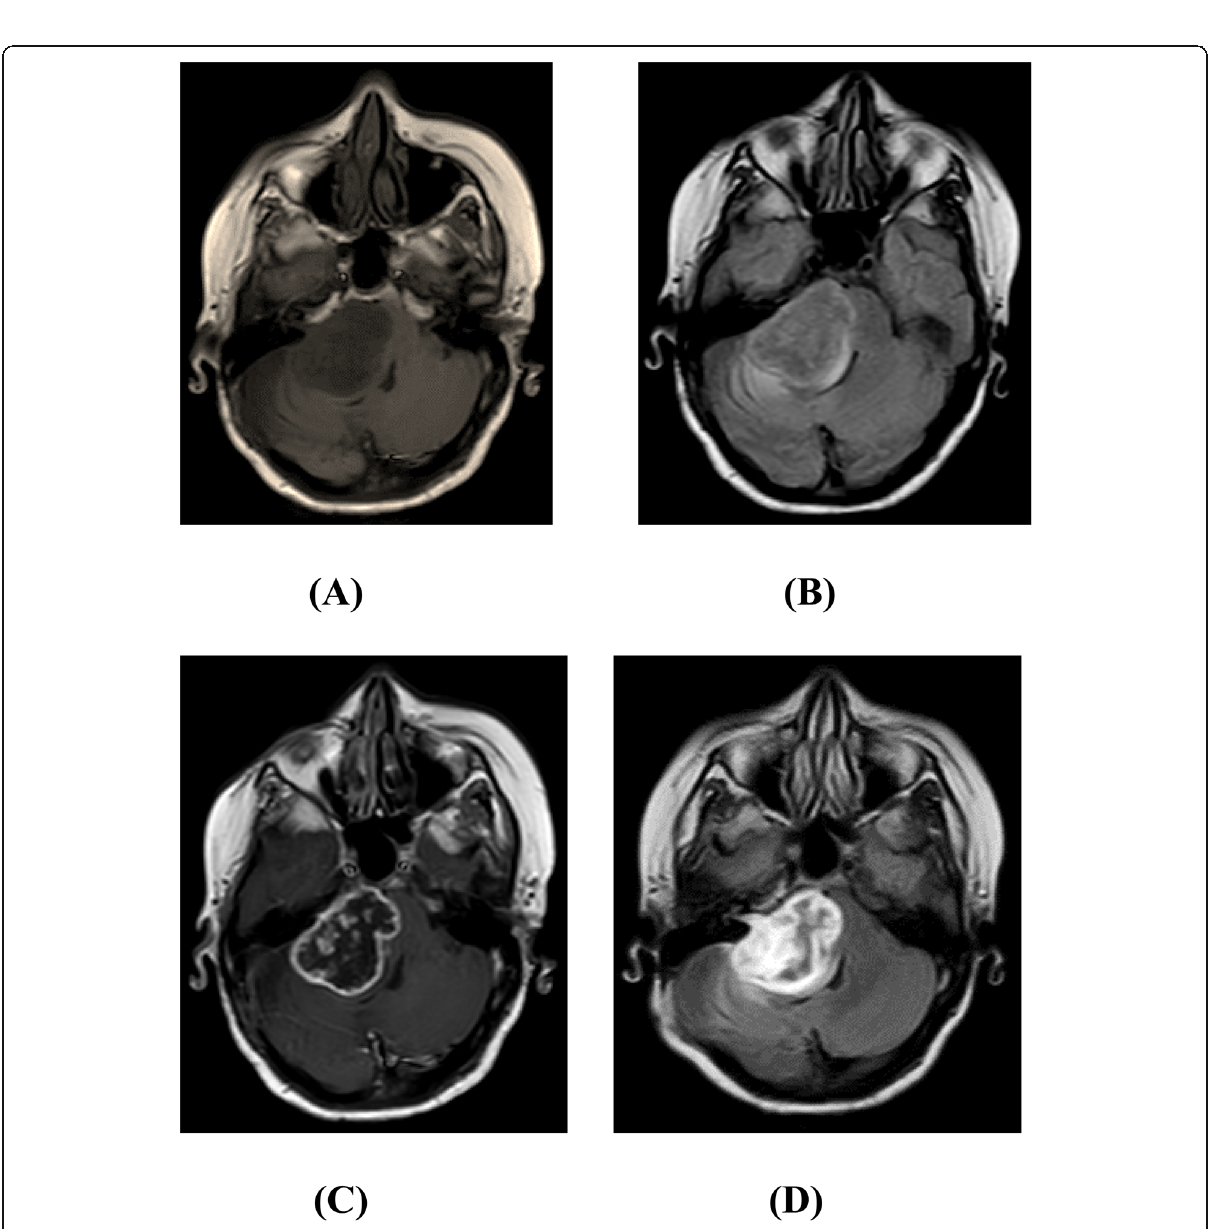
Fig. 3 Male patient aged 26 years with histopathologically proven right-sided vestibular schwannoma. A , B Axial pre-contrast T1WI and FLAIR respectively showed well defined extra-axial space-occupying lesion centered at the right cerebellopontine angle (CPA). It displayed low signal intensity on T1WI and intermediate signal intensity on FLAIR image. C Axial post-contrast T1WI showed peripheral non-homogenous enhancement with predominant internal non-enhancing cystic component. D Axial post-contrast FLAIR showed more extensive heterogeneous enhancement of the mass signifying a more solid component of the tumor. In addition, intra-canalicular extension into the internal auditory canal was more clearly demonstrated (trumpeting of the porus